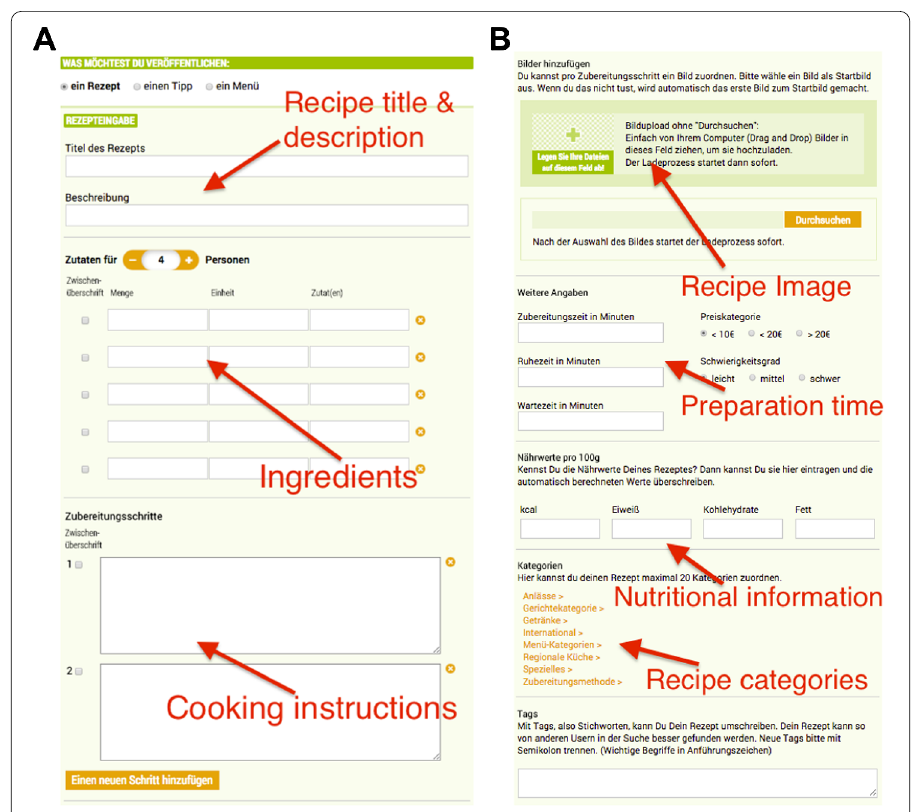
Figure 3 The upload view of Kochbar.de. Plot ( A ) shows the top part of the form with the structured ingredients and cooking instructions input widgets ( B ) presents the bottom part of the upload form, allowing the user to upload an sample image. This part also offers the possibility to assign the recipe to different categories, difficulties and price levels